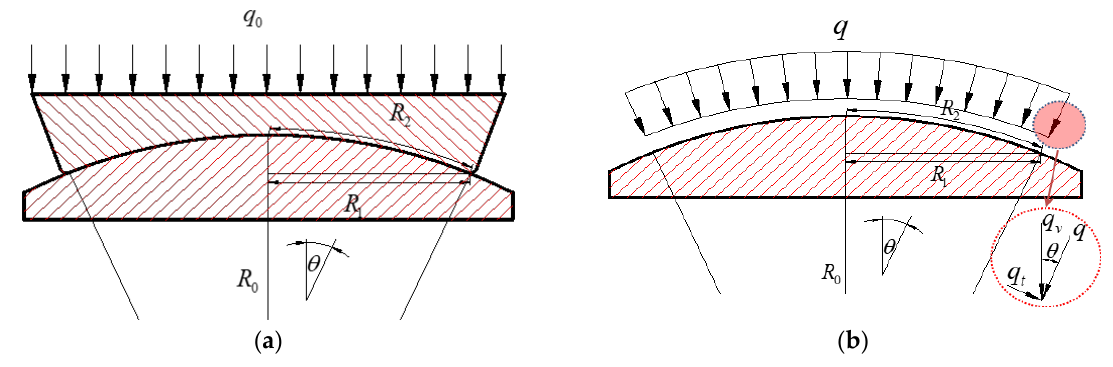
Figure 3. Force transmission diagram: ( a ) the force transmitted from the tower to the top plate; ( b ) the force transferred from the top plate to the bottom basin.